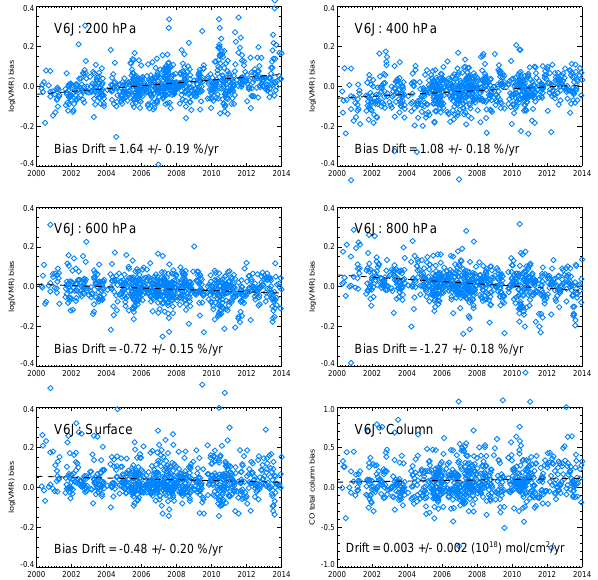
Figure 9. Time series plot showing V6 TIR/NIR (V6J) bias trends based on NOAA profiles.